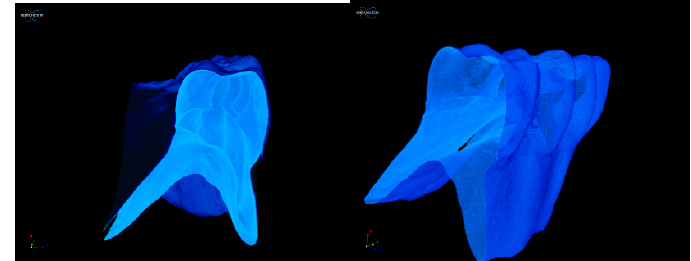
Figure 16. Slice images using micro-CT performed on a sample of the 3D-printed denture.